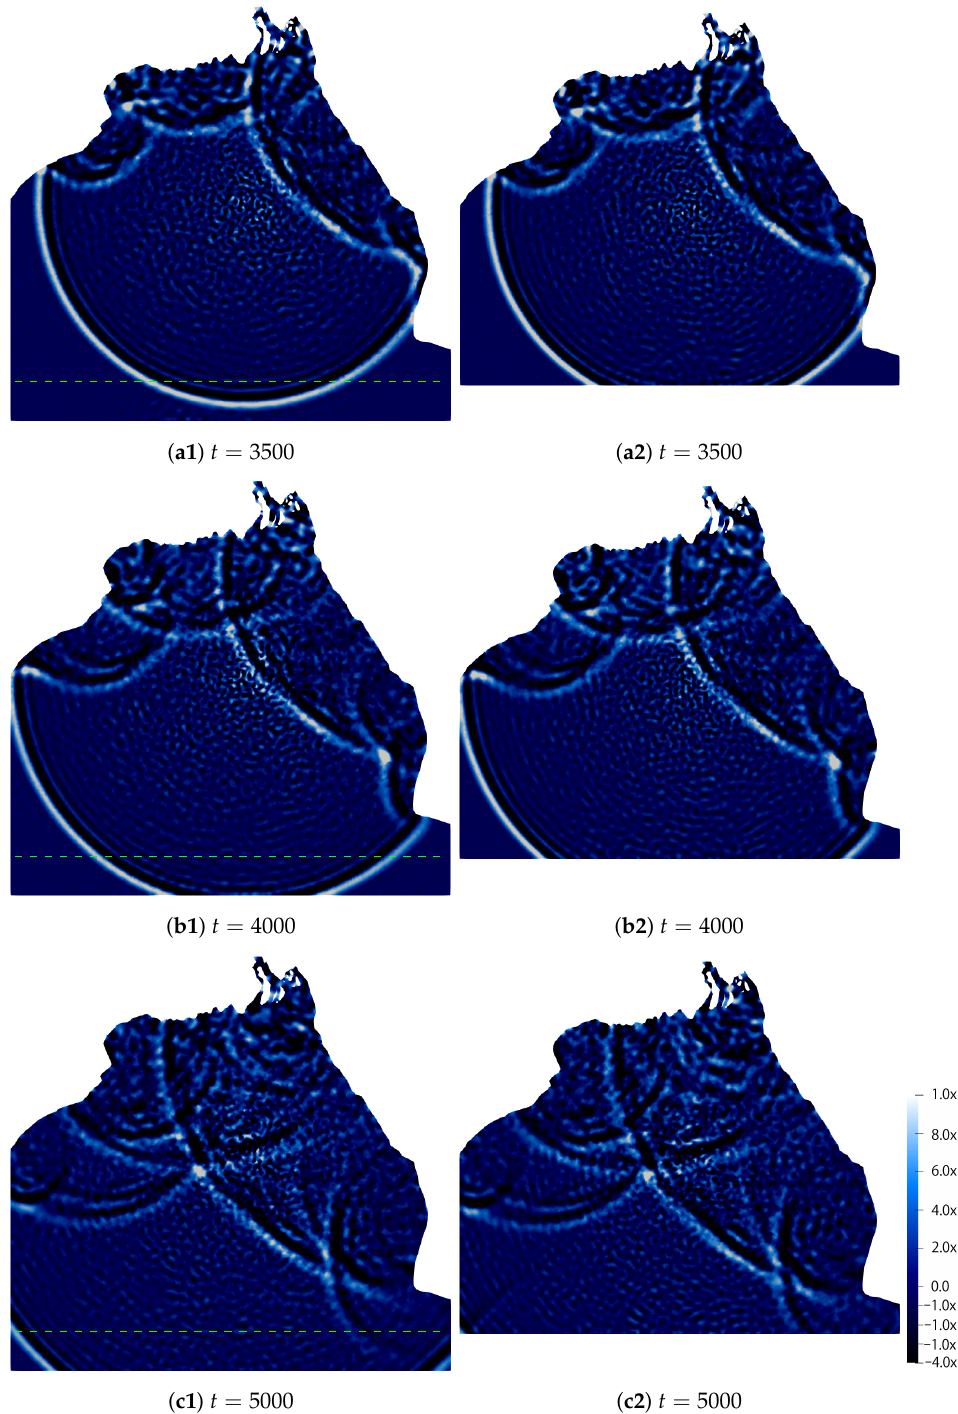
Figure 14. Contour plot of η n by LG2 with Γ = ¯ Γ D ∪ ¯ Γ T for the extended domain ( left ) and for the h original domain ( right ) on the Bay of Bengal for t = 3500,4000 and